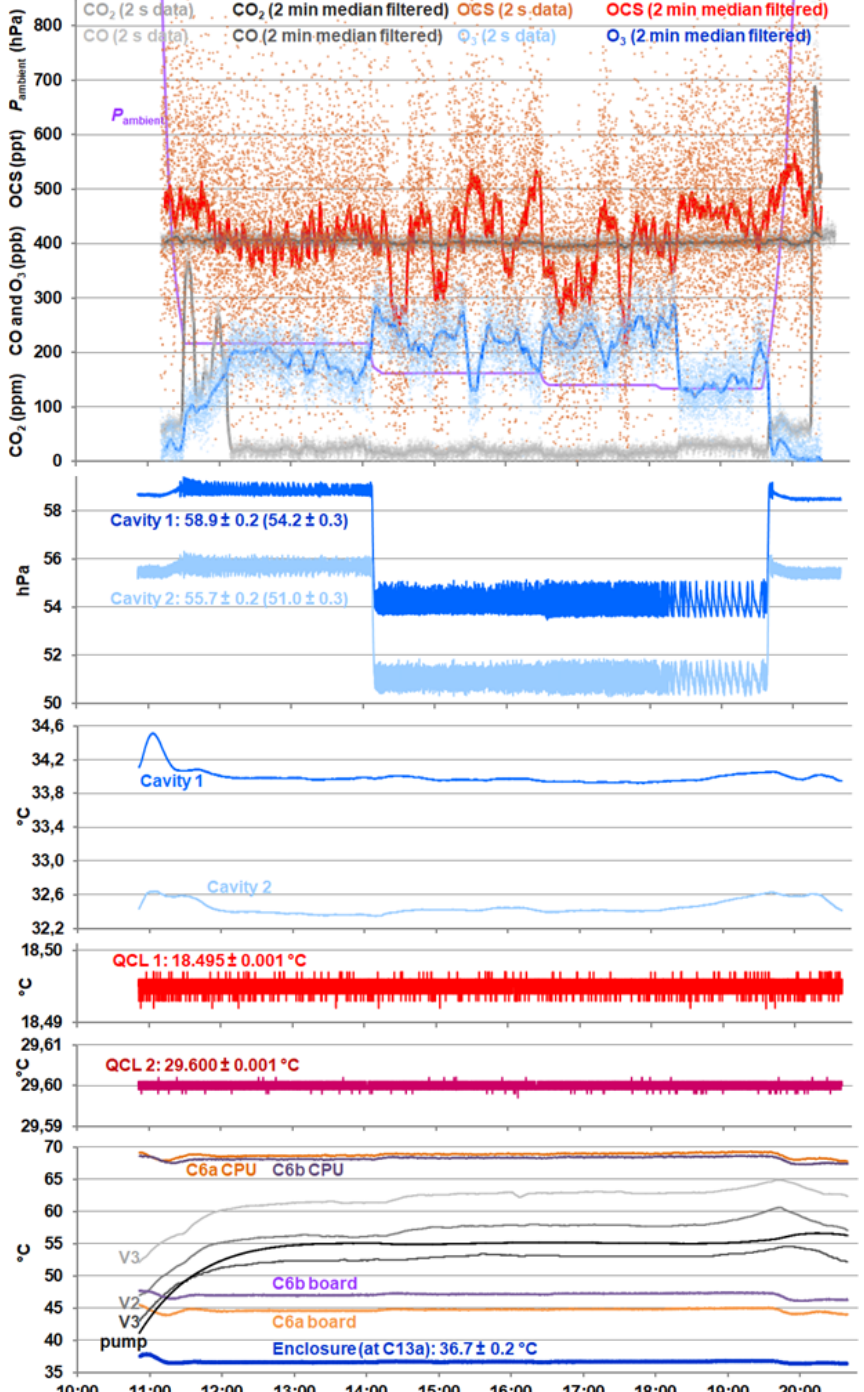
Figure 13. From top to bottom: AMICA trace gas observations, cavity pressures and temperatures, QCL temperatures, and other selected temperatures in the enclosure and powerbox recorded during the SouthTRAC flight on 12 November 2019 from Rio Grande,